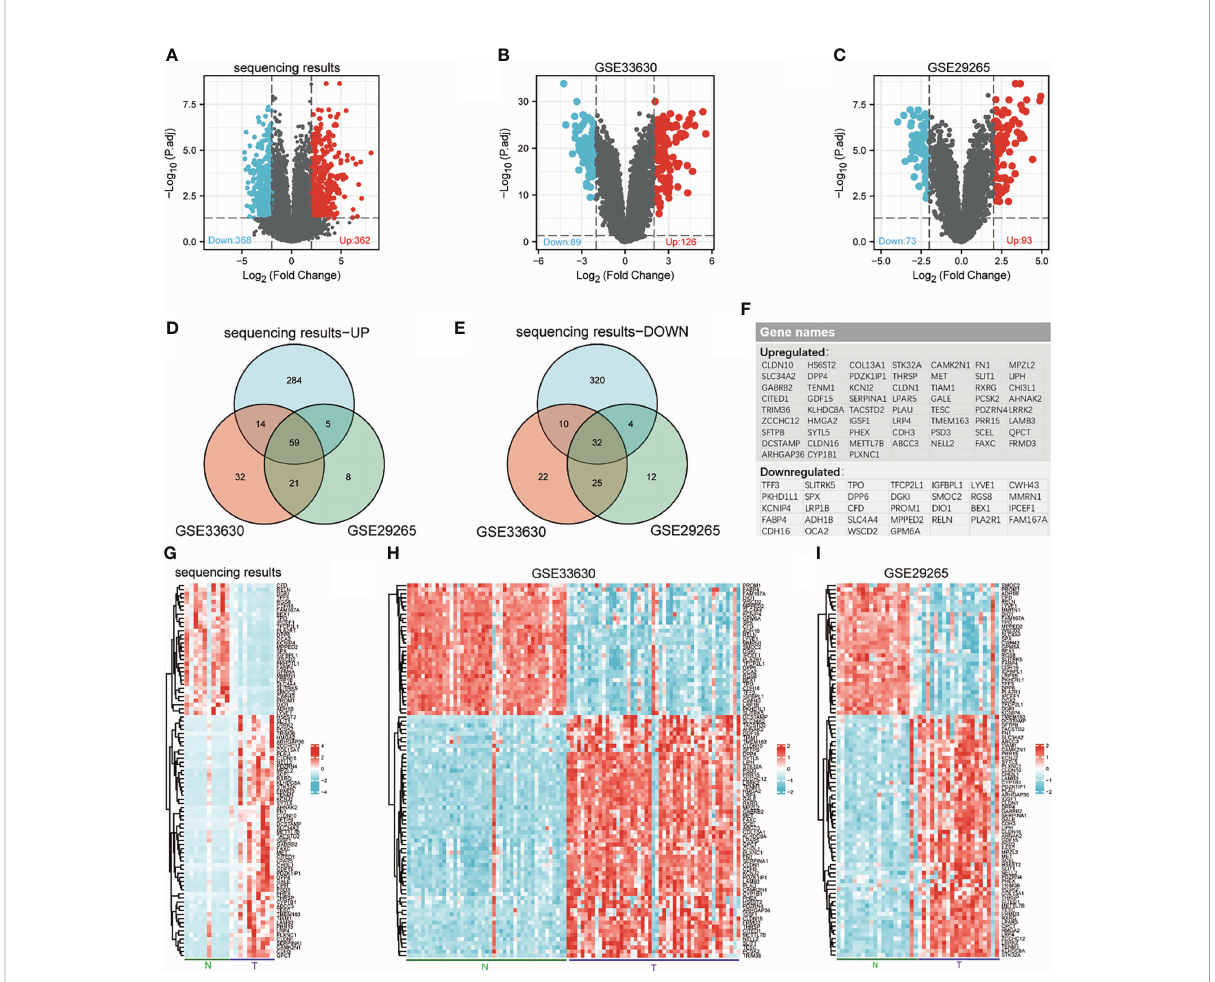
FIGURE 1 Identi fi cation of differentially expressed genes (DEGs). Volcanic maps for each data set: downregulated genes (blue dots) and upregulated genes (red dots) in THCA compared with normal thyroid; transcriptome sequencing results (A) , GSE33630 (B) , GSE29265 (C) . Venn diagrams: 59 overlapping upregulated genes in sequencing data, GSE33630 and GSE29265 (D) , 32 overlapping downregulated genes in sequencing data, GSE33630 and GSE29265 (E) . The names of 91 overlapping differentially expressed genes (F) . Heatmaps for each data set show the expression data of 91 genes: transcriptome sequencing results (G) , GSE33630 (H) , GSE29265 (I)